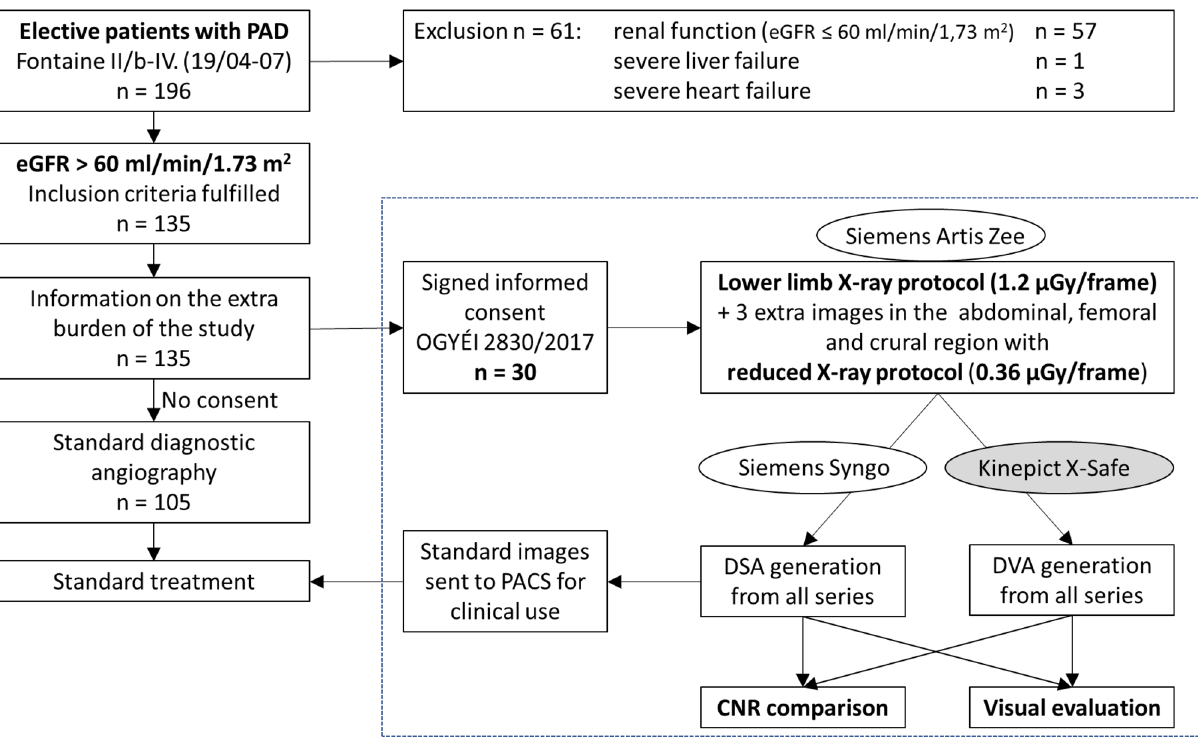
Figure 1. Flowchart of the study. Following the enrollment procedure, the selected patients were redirected to the study module (dashed square), where the endpoints (CNR comparison and visual evaluation) were reached in a fully anonymized manner. Although both normal and low-dose images were acquired during the examinations, only the normal dose DSA images were used for diagnostic purposes. DVA images were generated retrospectively from the raw unsubtracted series by using the Kinepict Medical Imaging Tool v.3.0 (Kinepict Health Ltd, Budapest). Both the CNR comparison and visual evaluation were performed retrospectively. PAD: Peripheral Artery Disease; DSA: Digital Subtraction Angiography; DVA: Digital Variance Angiography, PACS: Picture Archiving and Communication System; CNR: Contrast-to-Noise Ratio. OGYÉI: National Institute of Pharmacy and